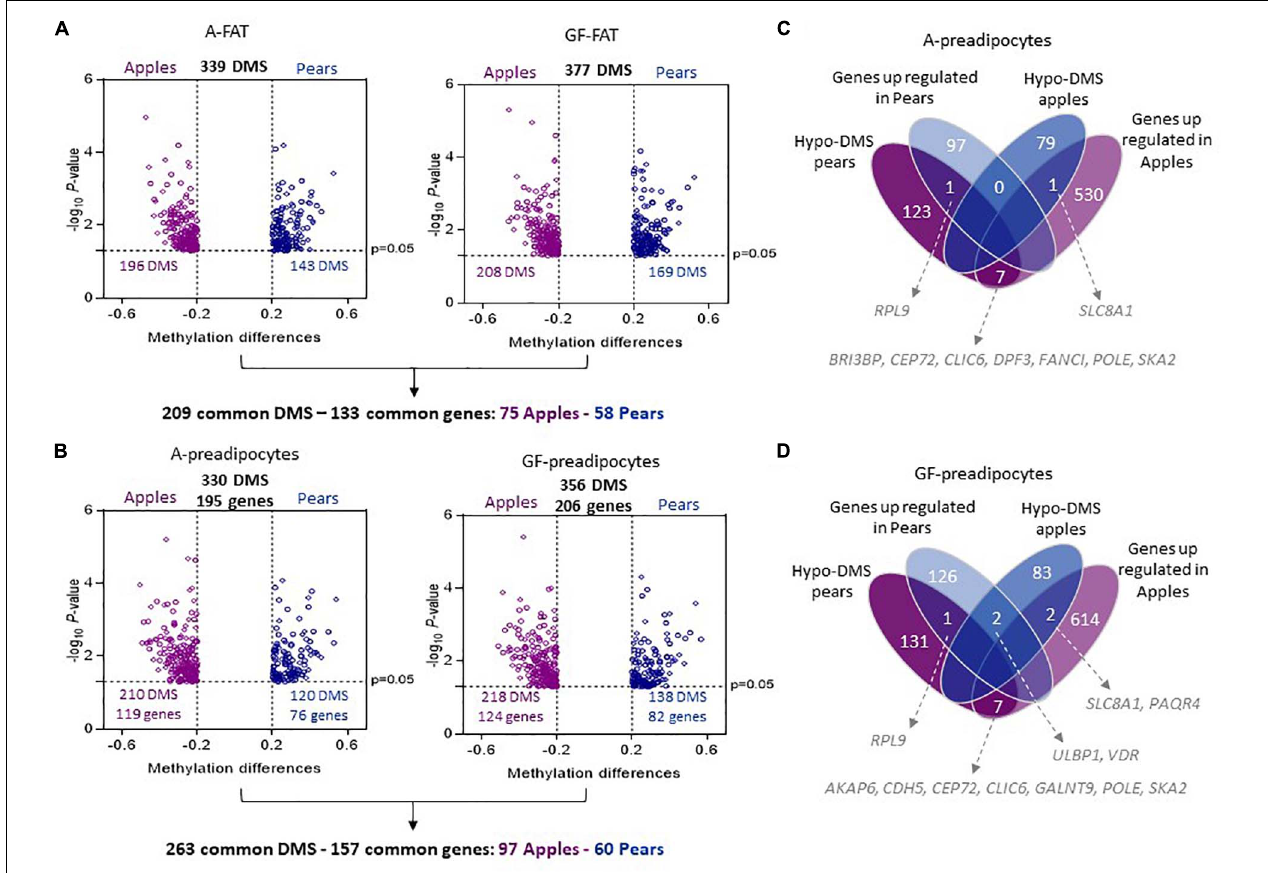
FIGURE 1 | Differentially methylated sites between apple and pear-shaped women in A-FAT and GF-FAT. (A,B) Volcano plot showing differences in DNA methylation between 10 apple and 7 pear-shaped subjects in A- FAT ( A -left side), GF-FAT ( A -right side), A-preadipocytes ( B -left side), and GF-preadipocytes ( B -right side). Each point represents a CpG site significantly differentially methylated with a β -value difference between both groups (methylation difference Apples vs. Pears) superior to 0.2. Purple color represents the sites more methylated in Apples. Blue color represents the sites more methylated in Pears. (C,D) The Venn diagrams represent the number of differential expressed genes and methylated sites between 10 apples and 7 pears women in A-preadipocytes (C) and GF-preadipocytes (D)